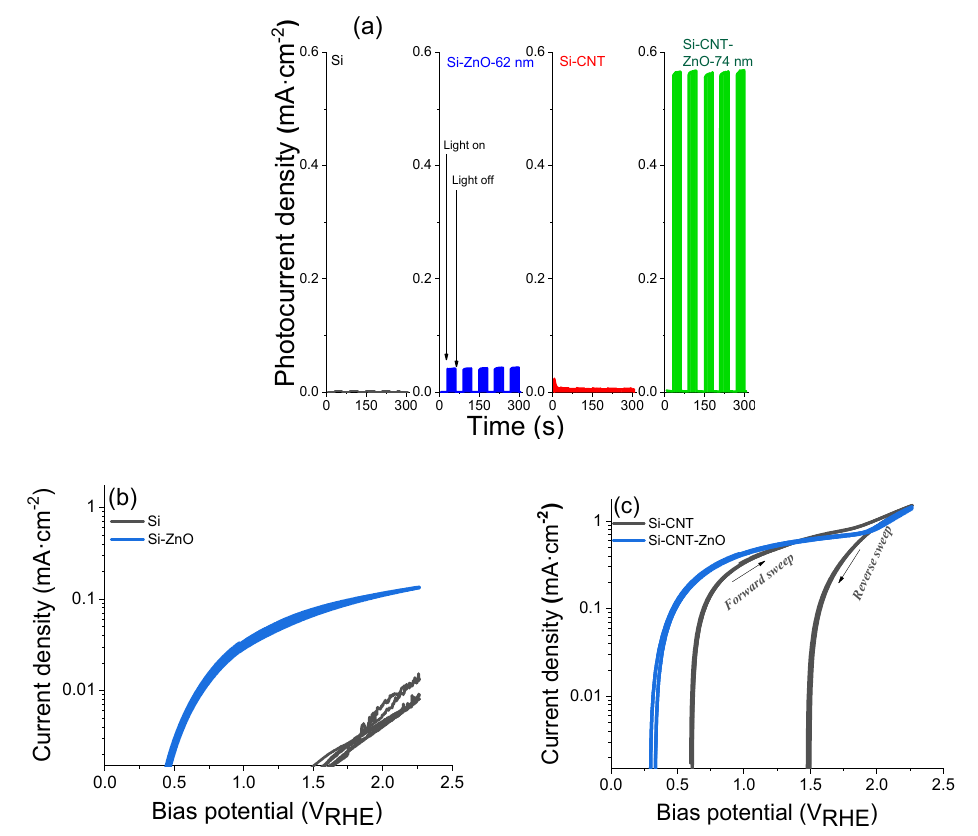
Figure 4. Chronoamperometric measurements at 1.23 V RHE ( a ) and the cyclic voltammetry at 0.1 V/s sweep rate for the noncoated and ZnO-coated Si ( b ) and Si-CNT ( c ) substrates. The thickness of ZnO is 74 nm on the CNTs and of 62 nm on Si.